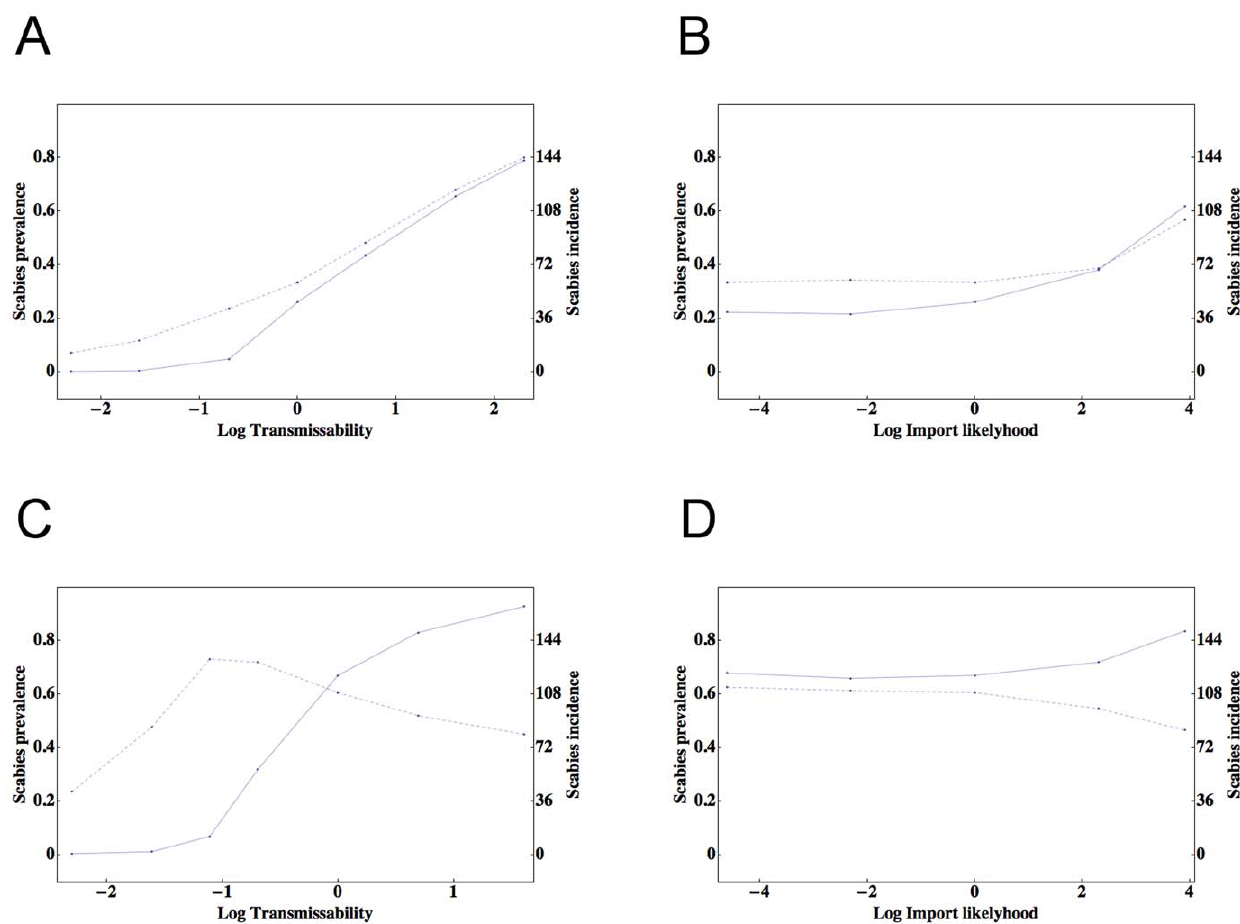
Figure 6. Prevalence and incidence rates for scenario 1 (a, b) and 2 (c, d). Effects on prevalence and incidence rates per 100 child-years (solid and dashed lines, respectively) of scabies in the 0–10 year-old age group as a function of the natural logarithm of the transmissibility Q (a, c), and as a function of the natural logarithm of the likelihood of importation J (b, d). For convenience, baseline transmissibility and the probability of importation are rescaled to the value 1 hence their log values are zero. Each point is the average of 24 one-year